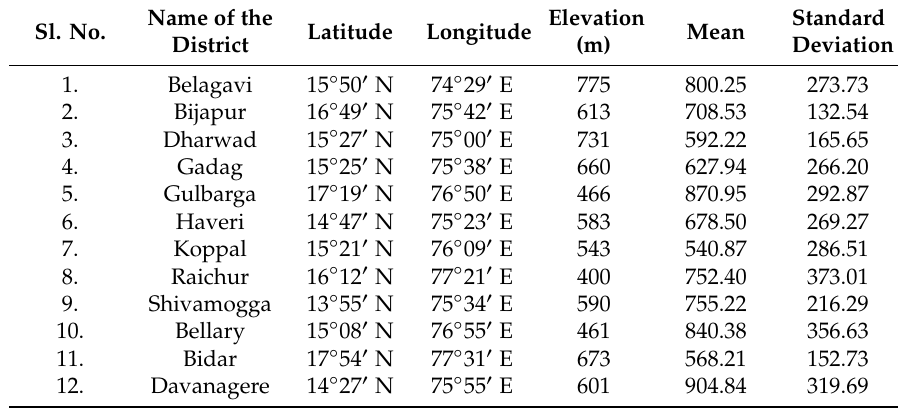
Table 1. The co-ordinates, altitude, mean and standard deviation of yield data for 12 major sorghum growing districts considered in this